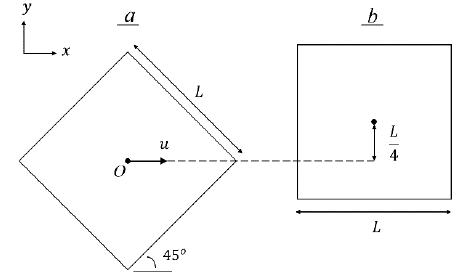
Fig. 3 Definition sketch of initial setup for collision test. Cube “ a ” on left and cube “ b ” on right.